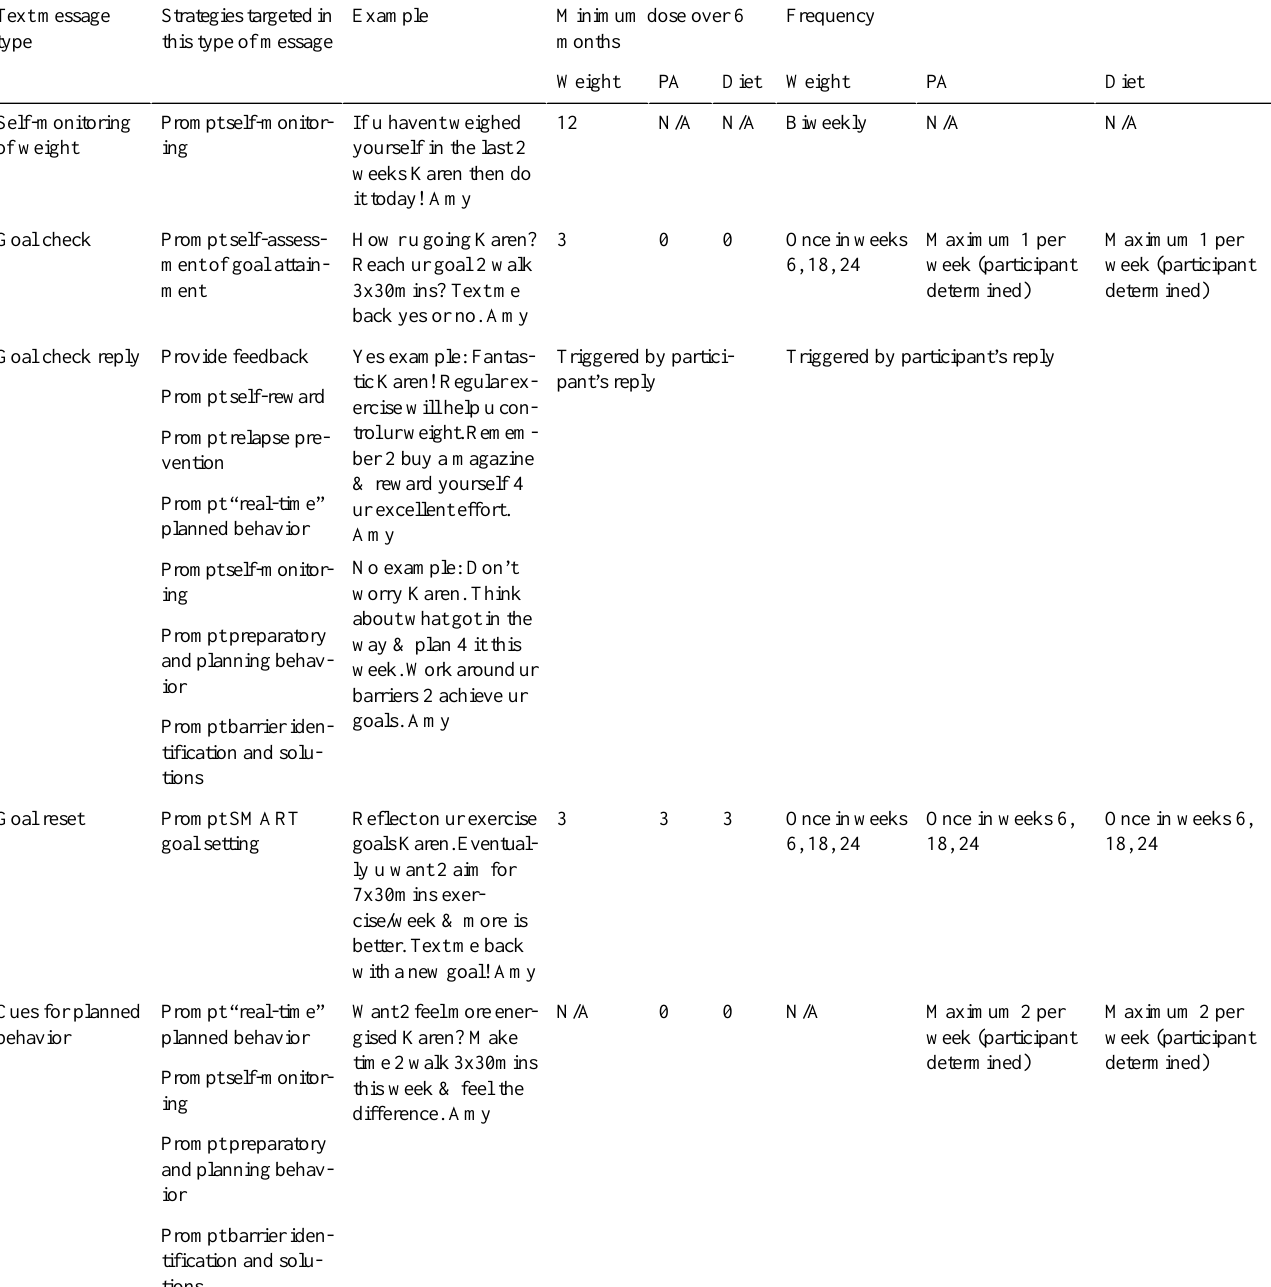
Table 1. Examples of how self-regulation strategies were targeted across the five different types of text